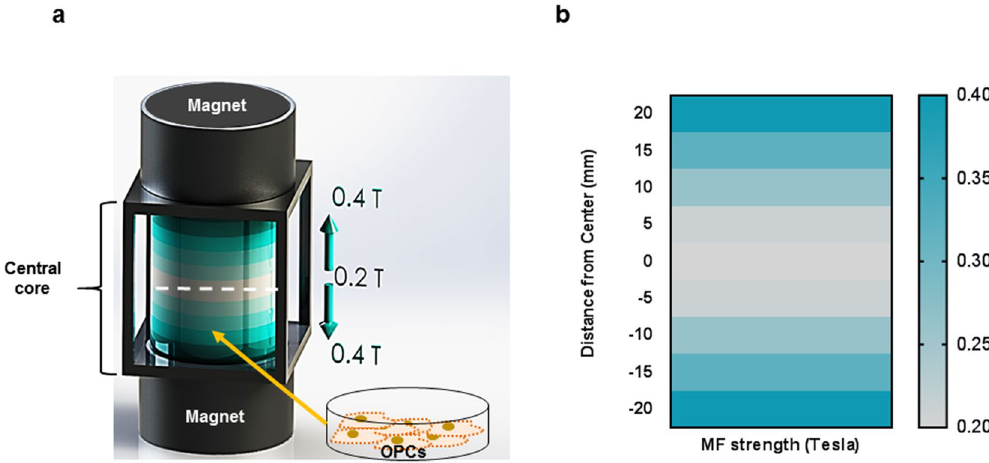
Figure 1. Schematic Illustration of the SMF stimulation set-up. ( a ) Two parallel magnets with opposite polarity produce a uniform static magnetic field in the central core. The magnetic induction range represented by the shaded blue columns. The field intensity varies from 0.2 T at the center line (white dashed) to 0.4 T at the base of the two magnets. The OPCs are placed at a distance of 1 cm from the base to expose them to 0.3 T magnetic field. ( b ) The characterisation of the magnetic field strength with respect to the vertical distance from the center line towards the base of the two